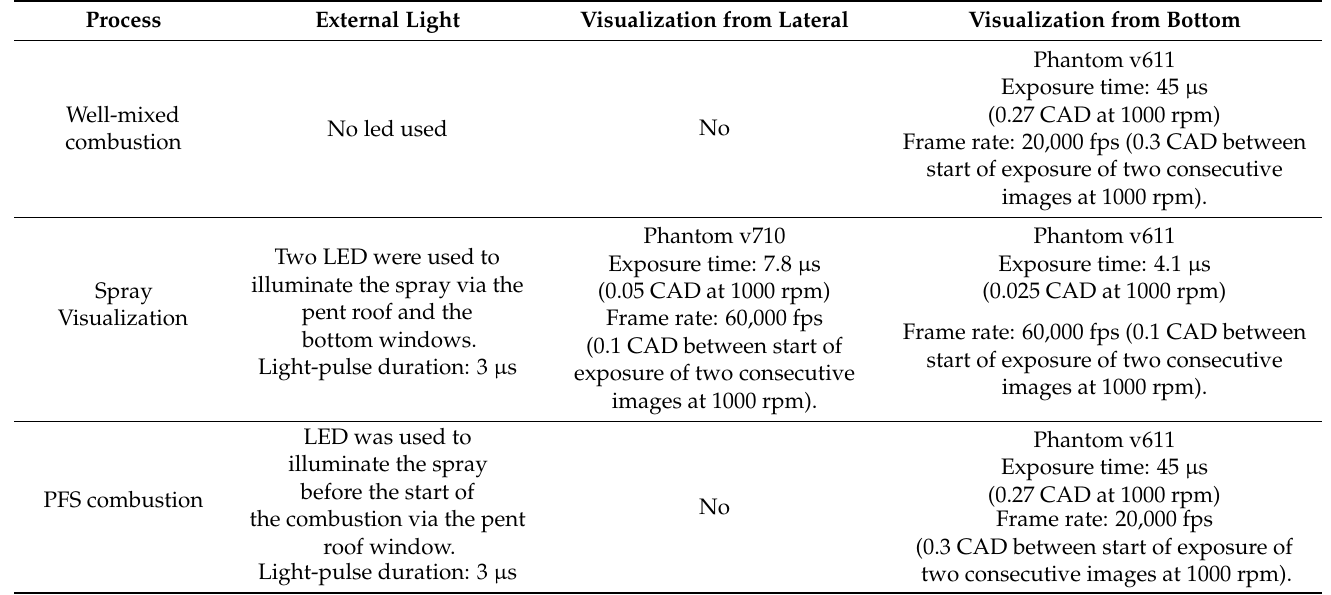
Table 2. Experimental Setup and Settings for the optical